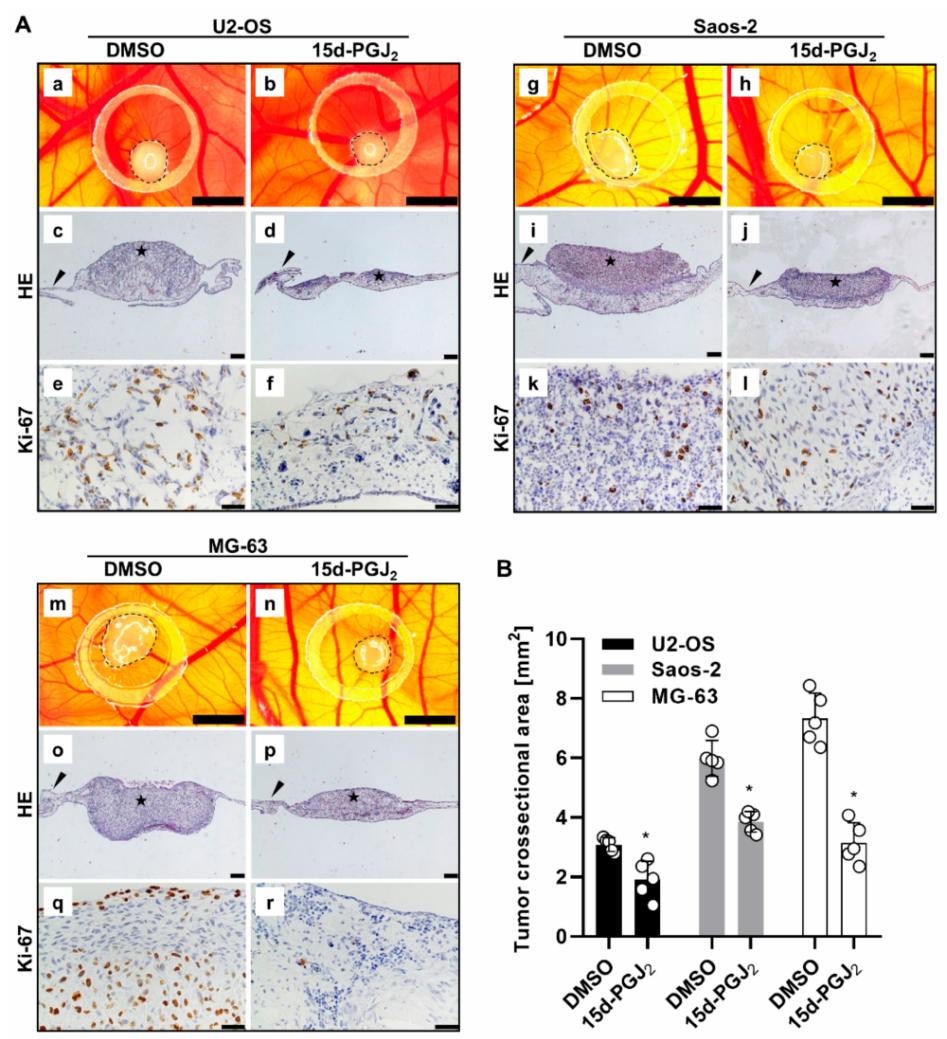
Figure 5. 15d-PGJ 2 reduces cell proliferation in OS cells grafted ex ovo on chicken chorioallantoic membrane (CAM). ( A ) Representative images display U2-OS, Saos-2, and MG-63 OS xenografts treated with vehicle control (DMSO concentration corresponding to 20 µ M 15d-PGJ 2 , 0.04%; n = 5) or with 20 µ M 15d-PGJ 2 (n = 5). Microphotographs display differences in solid tumor formation for control (DMSO) and 15d-PGJ 2 -treated OS cells (U2-OS ( a , b ); Saos-2 ( g , h ); MG-63 ( m , n )). Xenografts were photographed through a stereo microscope directly on cam (scale bar = 2 mm). Haematoxylin- eosin (HE) staining of cross-sections of the xenografts display the inhibiting effect of 15d-PGJ 2 on xenograft growth (U2-OS ( c , d ); Saos-2 ( i , j ); MG-63 ( o , p )). Arrowheads are indicative for the CAM tissue, stars for the OS xenografts (scale bar = 200 µ m). Immunohistochemical staining of the OS xenografts with anti Ki-67 antibody (U2-OS ( e , f ); Saos-2 ( k , l ); MG-63 ( q , r )) shows the proliferation of OS cells on the CAM (scale bar = 20 µ m). ( B ) Tumor size (crossectional area) was quantified by ImageJ. Data represent mean values (mm 2 ) and SD of five different tumors. Significance was estimated by t -test. (* p ≤